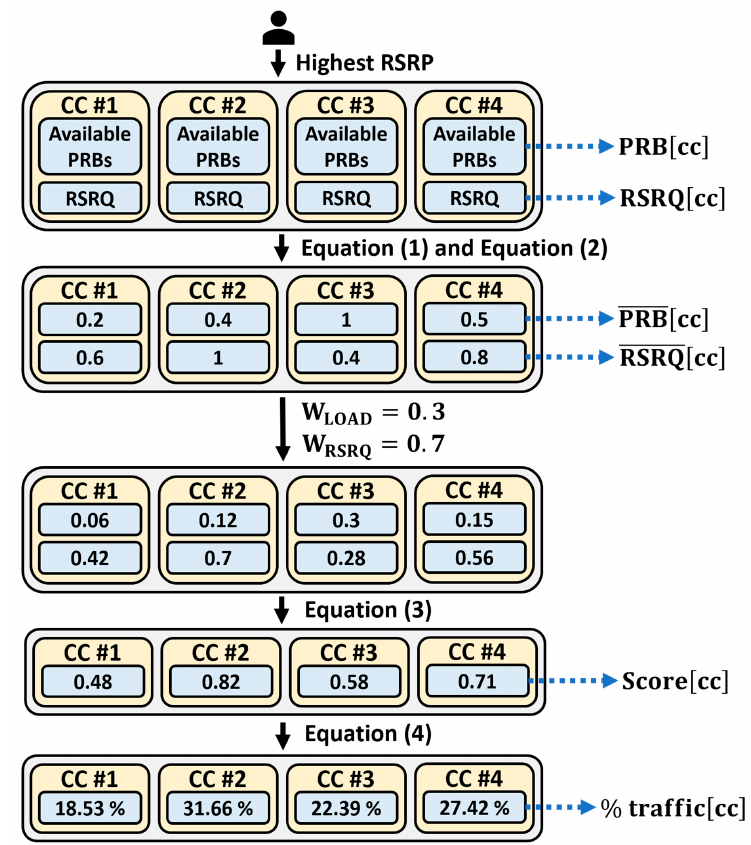
Figure 1. Example of the traffic steering solution with random initial values.